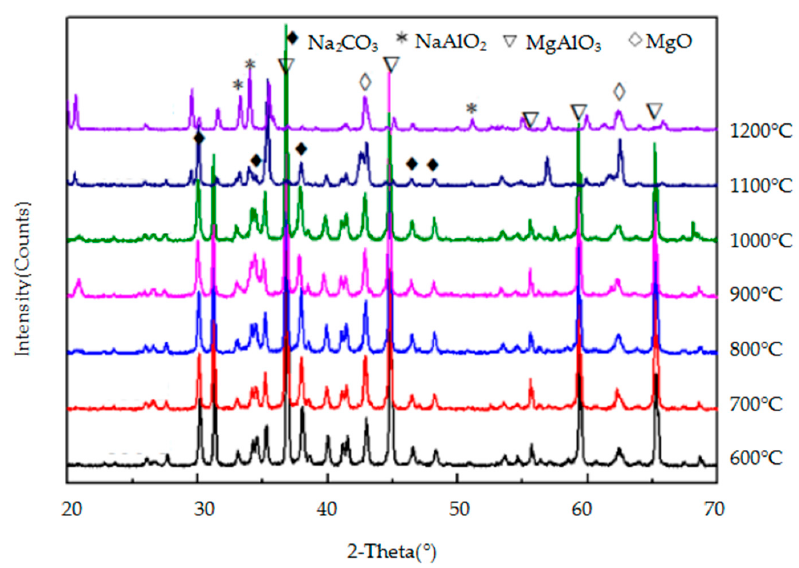
Materials 2018 , 11 , x FOR PEER REVIEW Figure 13. XRD patterns of the products of the reaction between MgO·Al 2 O 3 and Na 2 CO 3 . Figure 13. XRD patterns of the products of the reaction between MgO · Al 2 O 3 and Na 2 CO 3 .